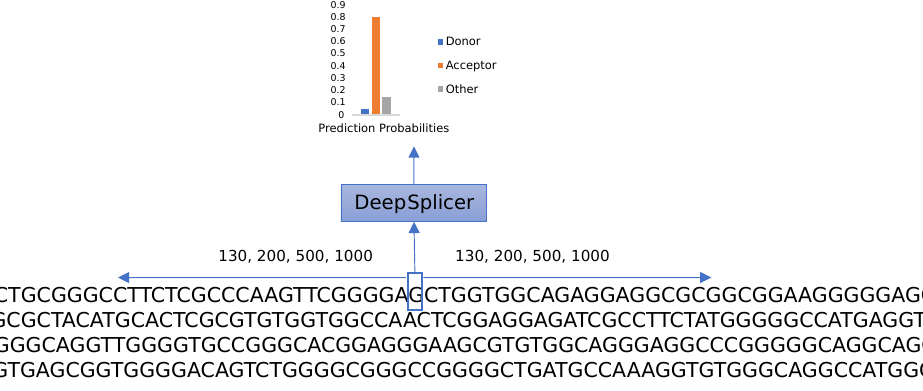
Figure 4. Deep Splicer prediction process. All nucleotides in a sequence are processed using a sliding window. The nucleotide in the middle of the sliding window is predicted to be a donor, acceptor, or other